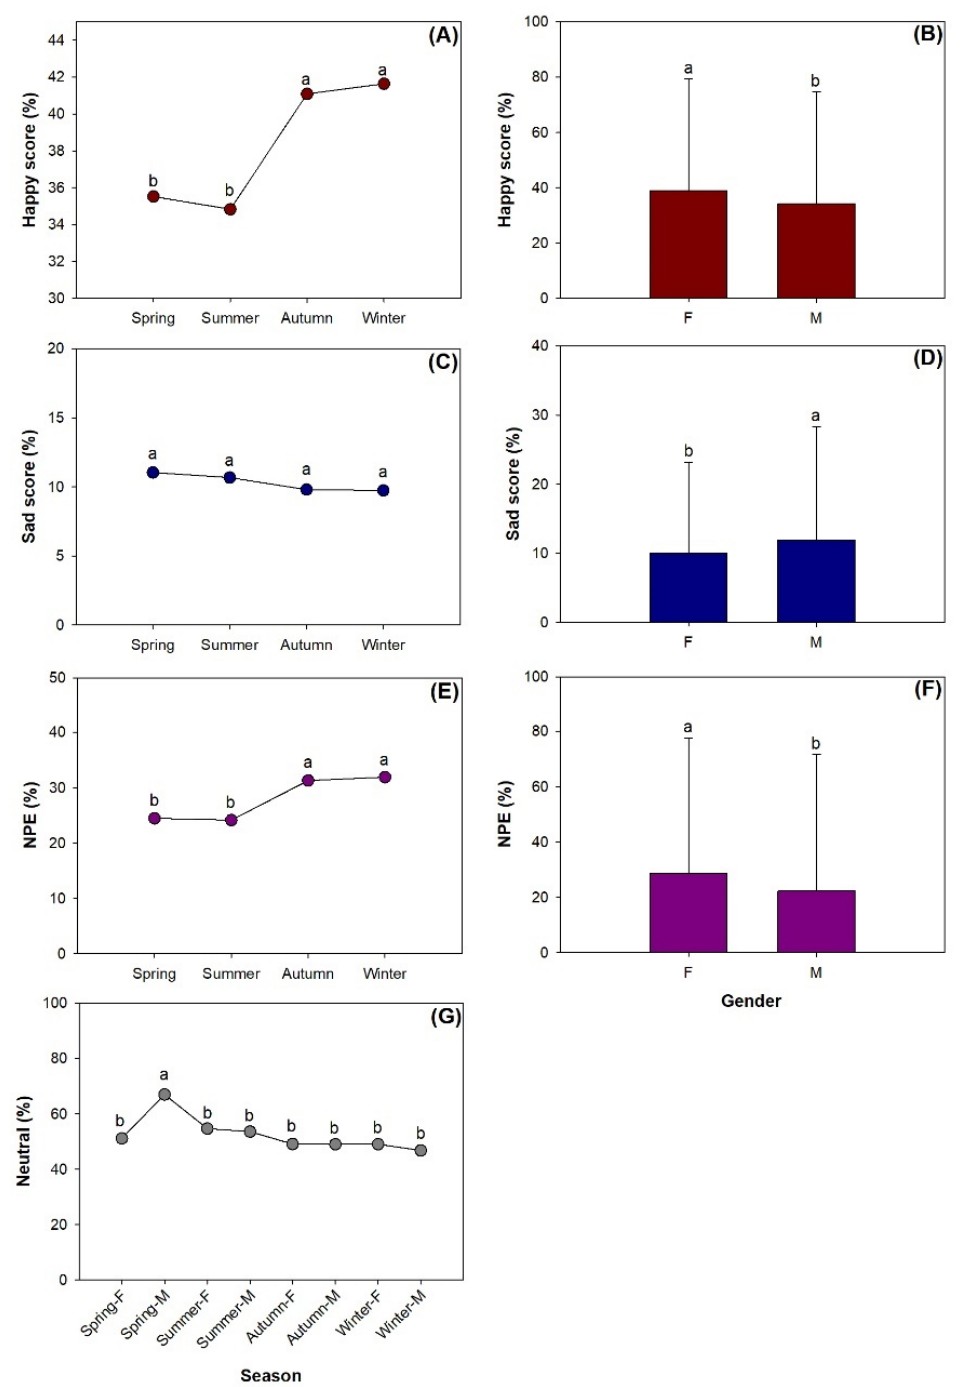
Figure 2. Dynamic changes of facial expression scores for happy ( A , B ), sad emotions ( C , D ), net pos- itive emotion index (NPE; E , F ), and neutral emotion ( G ) of community residents of differing genders (female, F; male, M) and seasonal dynamic of neutral scores for both genders. Error bars mark stand- ard deviations; different letters label significant difference identified by Duncan multiple range test at 0.05 level.